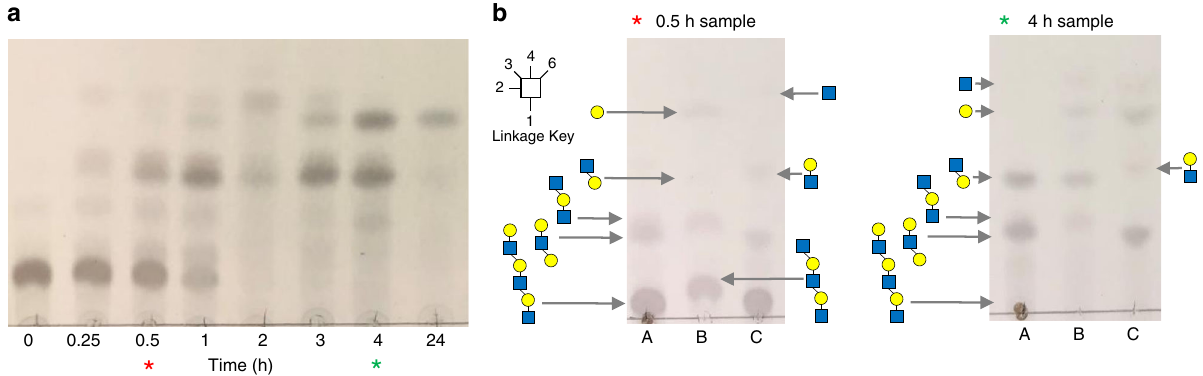
Fig. 5 Surface activity of mucin-grown A. muciniphila against TriLacNAc. a A. muciniphila cells were grown on PGM III, harvested and TriLacNAc added to assess surface enzyme activity. Samples were analysed at different time points following addition of TriLacNAc. Equivalent data for the Bacteroides species are shown in Supplementary Fig. 13. b Samples from two different time points of the A. muciniphila whole cell assay were incubated with two different exo- acting enzymes of known speci fi city to identify the products. The asterisks indicate the time points analysed. The top and bottom of the glycan structures shown is the non-reducing and reducing end, respectively. A: original sample, B: + β 1,4-galactosidase BT0461 GH2 , C: + broad-acting β -GlcNAc ’ ase BT0459 GH20 . For example, in both time points, the two different types of trisaccharides can be seen to be hydrolysed in the separate digests: (1) Gal β 1,4GlcNAc β 1,3Gal disappears in ‘ B ’ and products Gal and GlcNAc β 1,3Gal are now present, (2) GlcNAc β 1,3Gal β 1,4GlcNAc disappears in ‘ C ’ and products GlcNAc and Gal β 1,4GlcNAc are now present. These experiments were carried out once, but multiple pilot experiments were run and were consistent with the data shown. The source data are provided in the source data fi